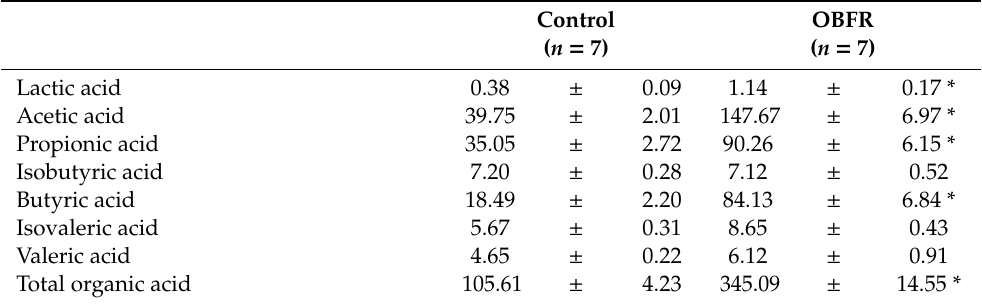
Table 3. E ff ects of feeding OBFR on organic acid concentration of rat’s cecal contents (nM / g feces).